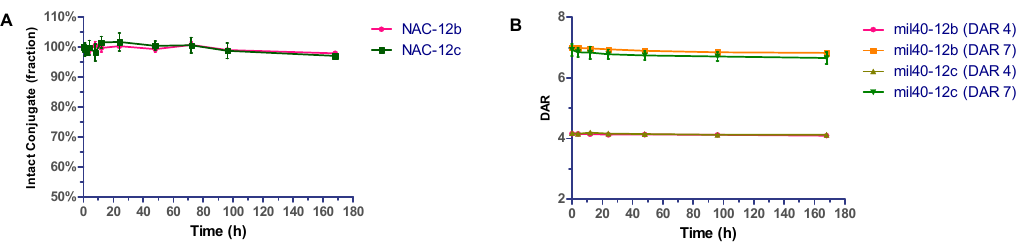
Figure 4. Stability assays of VA- and VC-based conjugates in PBS. Compound in phosphate buffered saline (PBS) (pH 7.4) were incubated at 37 °C for seven days. Error bars represent standard deviation from three independent experiments (triplicates). Results are shown as the mean ± SD. ( A ) Stability of NAC- 12b and NAC- 12c ; ( B ) Stability of VA- and VC-based ADCs loaded with four and seven drugs per antibody.